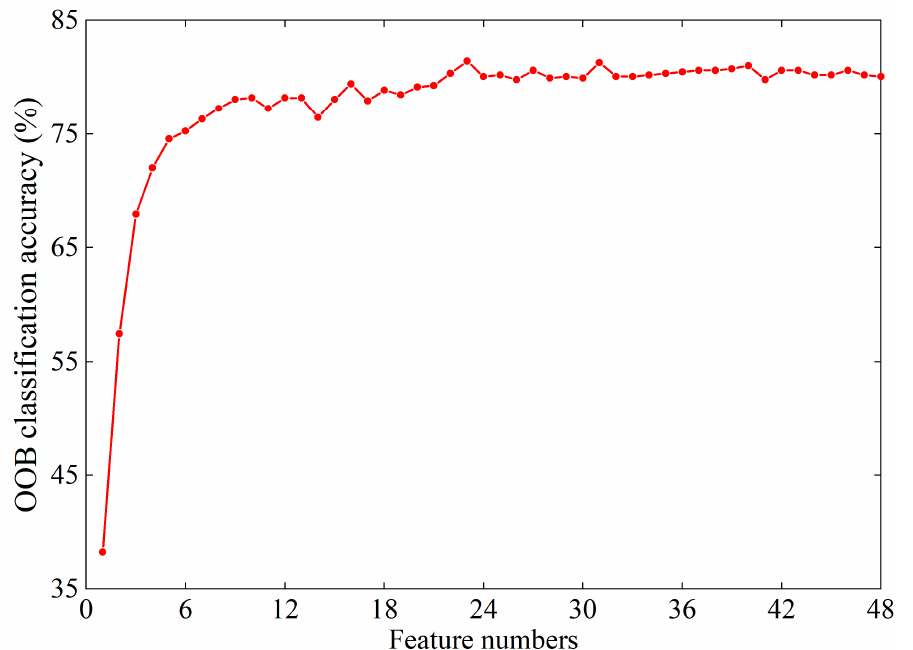
Figure 12. RF OOB classification accuracy with different numbers of MS features.